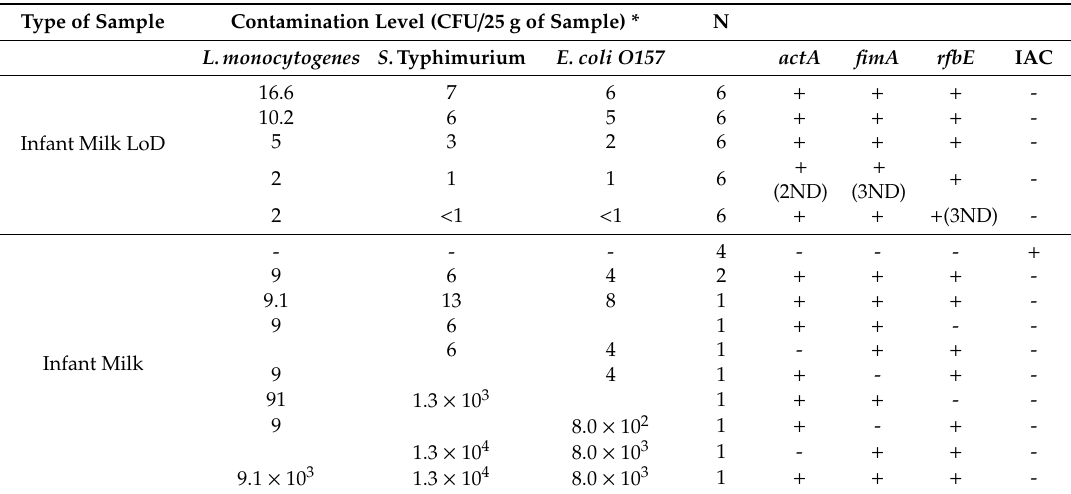
Table 4. Spiked samples.